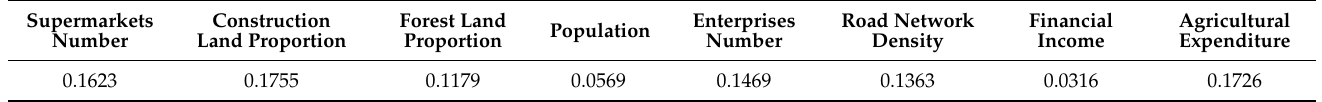
Table 2. The combination